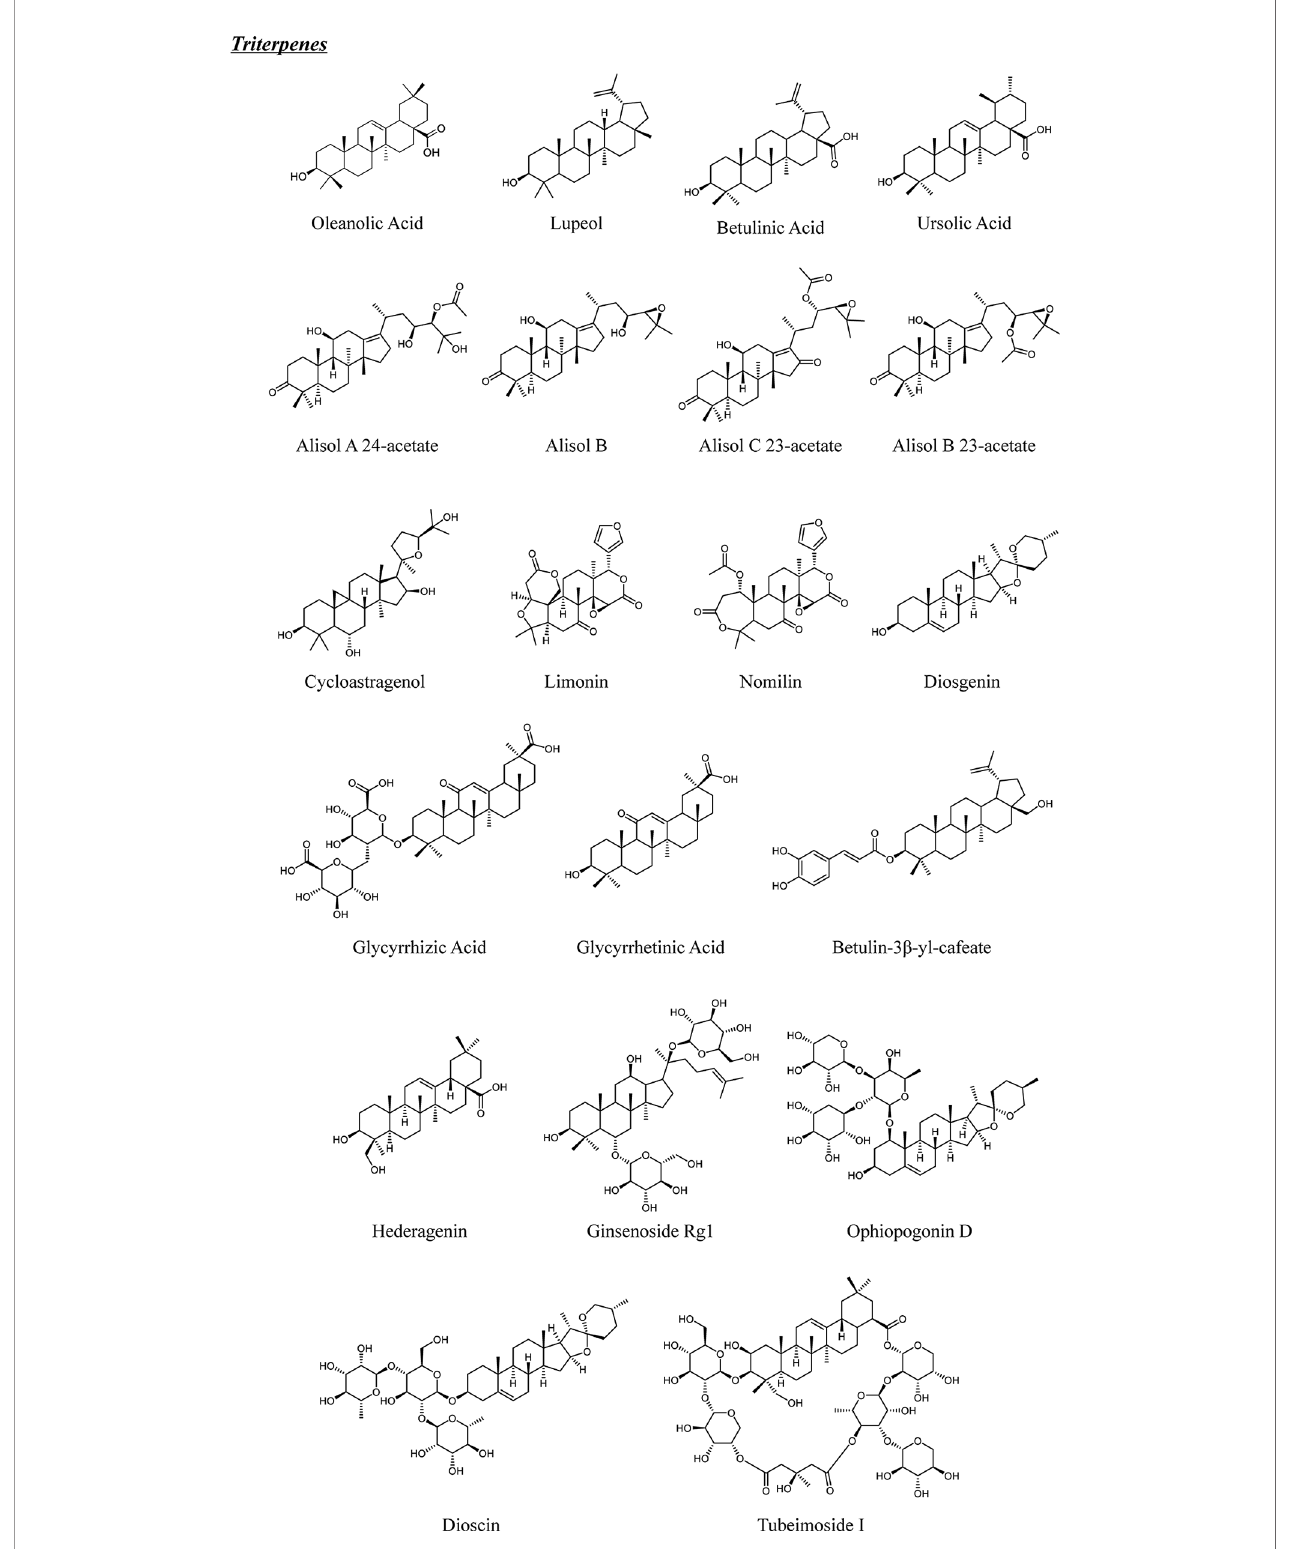
FIGURE 2 | Chemical structures of natural triterpenes from